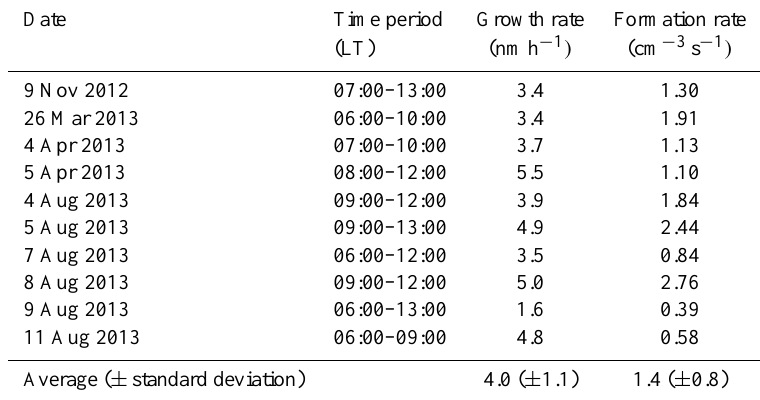
Table 2. Time periods defined as the new particle formation events and the particle growth and formation rates.